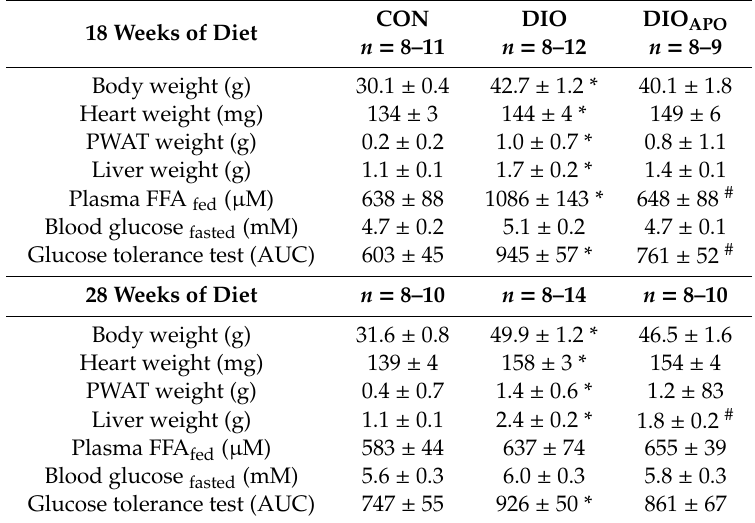
Table 2. Animal characteristics of chow fed controls (CON) and diet-induced obese C57BL / 6J mice with or without apocynin treatment (DIO and DIO APO